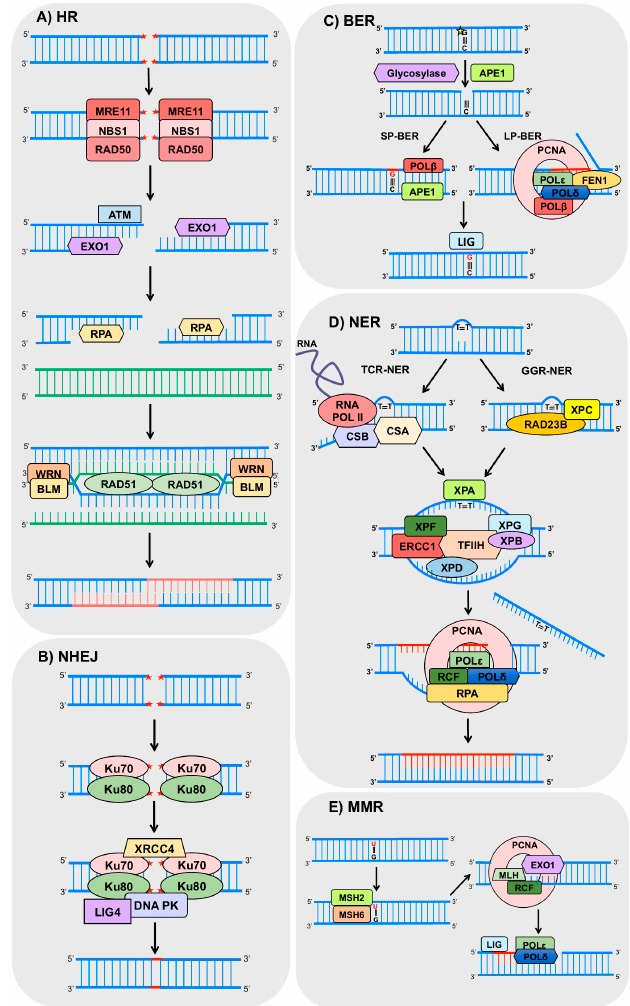
Figure 2. Schemes of the main DNA repair pathways reported to crosstalk with autophagy. The figures represent only the main steps for each pathway (indicated on the figure) and show only part of the proteins involved, focusing on those commented in the text to have a role on autophagy. HR (homologous recombination), NHEJ (non-homologous end joining), BER (base excision repair), NER (nucleotide excision repair), GGR (global genome repair), TCR (transcription-coupled repair), MMR (mismatch repair), MRE11 (double strand break repair, DSB, nuclease), RAD50 (human homolog of S. cerevisiae RAD50), NBS1 (Nijmegen breakage syndrome 1), ATM (ataxia telangiectasia mutated protein), EXO1 (exonuclease 1), RPA (replication factor A), WRN (Werner syndrome RecQ like helicase), BLM (Bloom syndrome REcQ like helicase), RAD51 (human homolog of S. cerevisiae RAD51), XRCC4 (X-ray cross complementing 4), DNA PK (DNA-dependent protein kinase), LIG4 (DNA ligase 4), APE1 (AP-endonuclease1), POL β (DNA polymerase beta), POL ε (DNA polymerase epsilon), POL δ (DNA polymerase delta), PCNA (proliferating cell nuclear antigen), FEN1 (flap endonuclease 1), LIG (DNA ligases), RNA POL II (RNA polymerase 2), CSA (Cockayne syndrome A), CSB (Cockayne syndrome B), XPC (xeroderma pigmentosum complementation group C), RAD23B: (human homolog B of S. cerevisiae RAD23), XPA (xeroderma pigmentosum complementation group A), XPF (xeroderma pigmentosum complementation group F), ERCC1 (excision repair cross-complementation group 1), TFIIH (transcription factor II H), XPB (xeroderma pigmentosum complementation group B), XPD (xeroderma pigmentosum complementation group D), XPG (xeroderma pigmentosum complementation group G), RCF (replication factor C), MSH2 (MutS homolog 2), MSH6 (MutS homolog 6), MLH (MutL homolog). The red stars represent DNA DSB lesions and the yellow star represents oxidized DNA